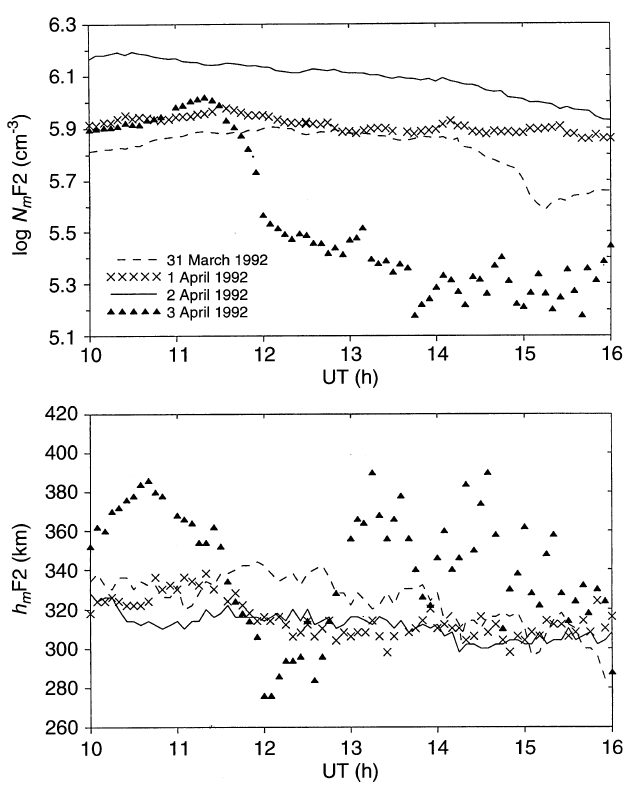
Fig. 1. Observed N 1992 during